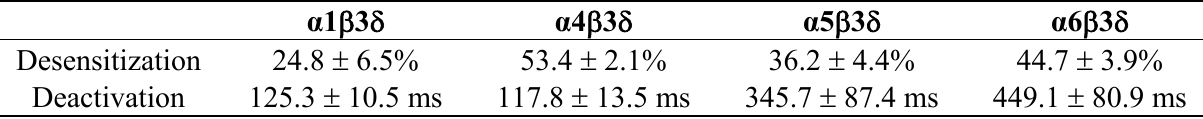
Table 1. Comparison of GABA current kinetics among α β 3 δ receptors with different α subunits. Adapted from [29]